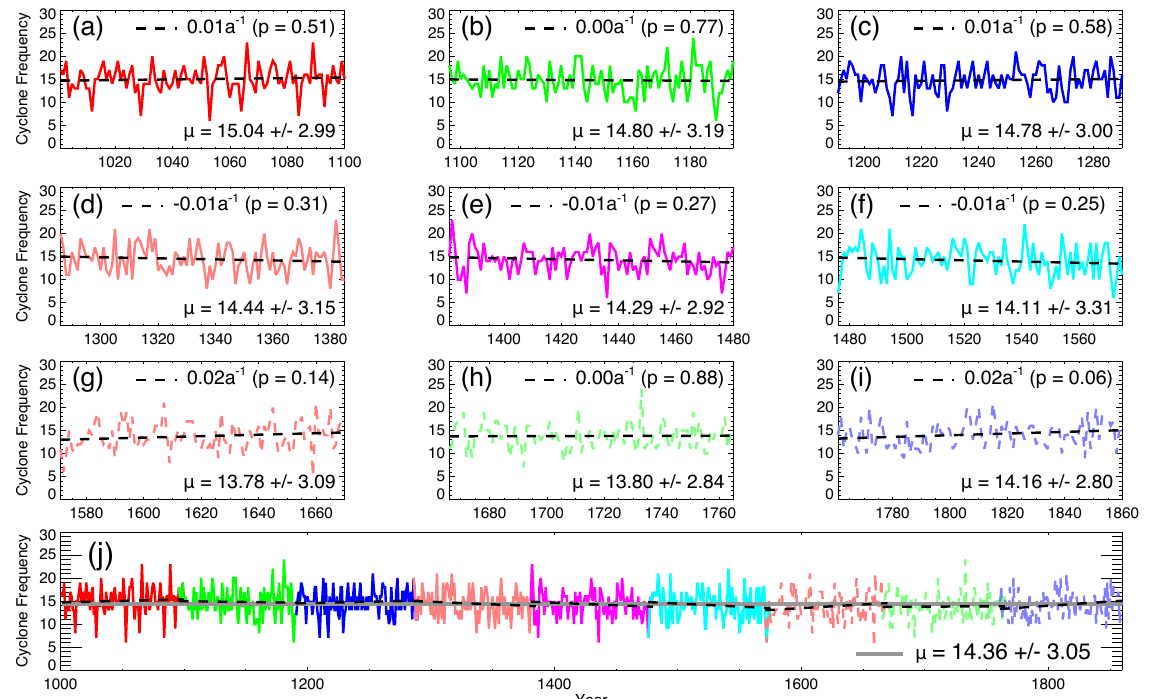
Fig. 4. Summertime (JJA) cyclone frequencies in the GFDL CM3 Pre-industrial Control simulation (perpetual 1860 conditions; Table 1) for selected 100yr periods. (a) 1001–1100. (b) 1096–1195. (c) 1191–1290. (d) 1286–1385. (e) 1381–1480. (f) 1476–1575. (g) 1571–1670. (h) 1666–1765. (i) 1761–1860. (j) Full control simulation, 1000–1860. The ordinary least squares trend for each time period is overlaid (dashed black line).